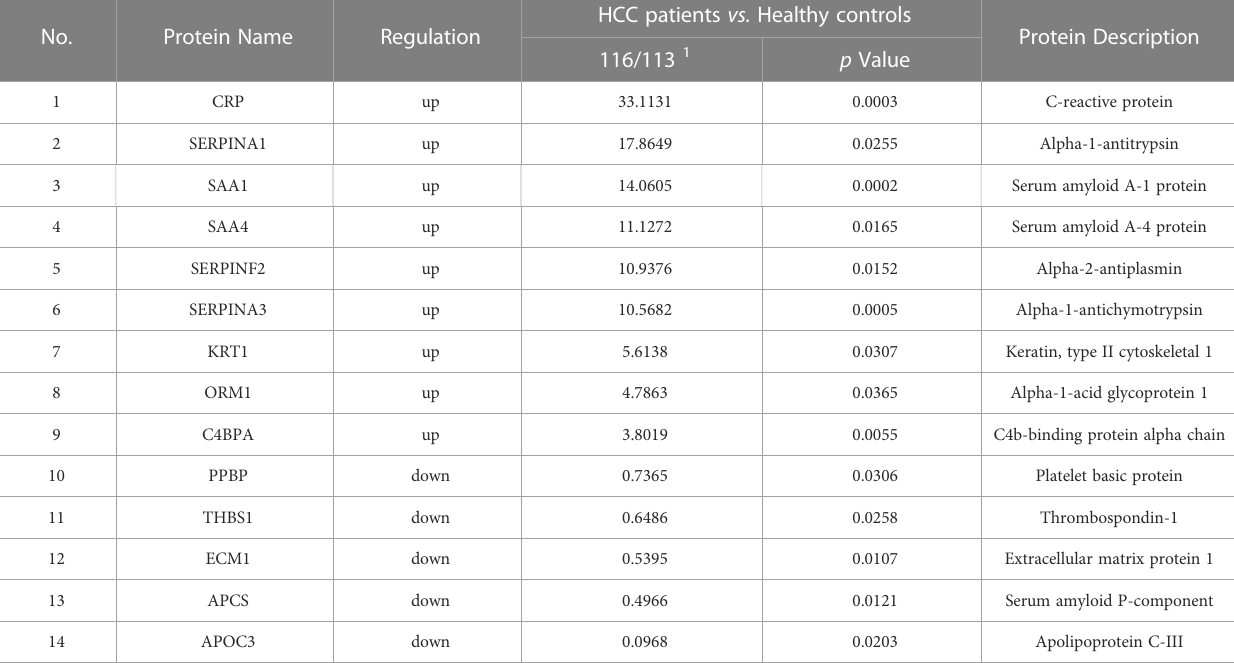
TABLE 4 Differentially expressed proteins (DEPs) associated with HCC metastasis.